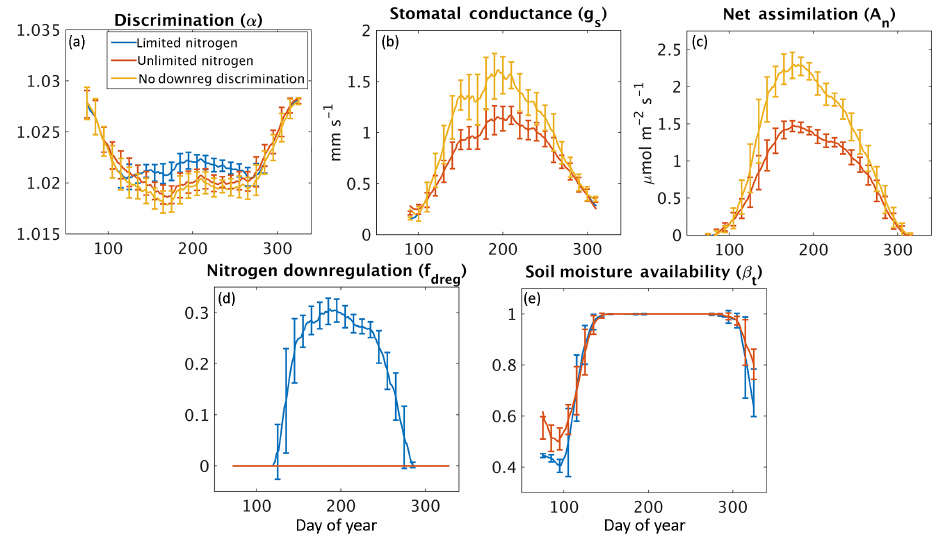
Figure 9. The seasonal pattern of discrimination (a) and diagnostic variables that explain the discrimination pattern in Fig. 8. The individual tiles provide behavior for days 75–325 for (a) α , (b) g s , (c) A n , (d) f dreg , and (e) β t . Where the no-downregulation discrimination model simulation is not shown, it is identical to the limited nitrogen simulation. Uncertainty bars represent 95% confidence intervals of interannual variation from 2006 to